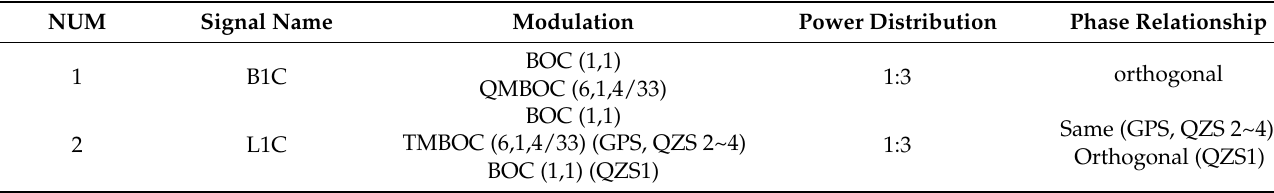
Table 1. Design scheme of L1C,